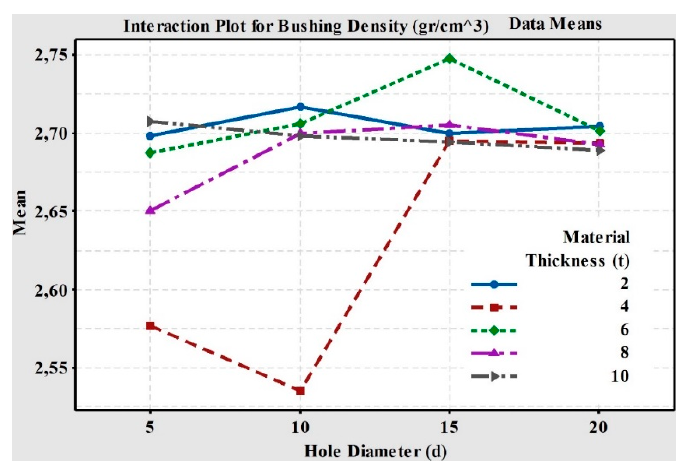
Figure 10. The interaction plot of the hole diameter and volume ratio of the bushing.